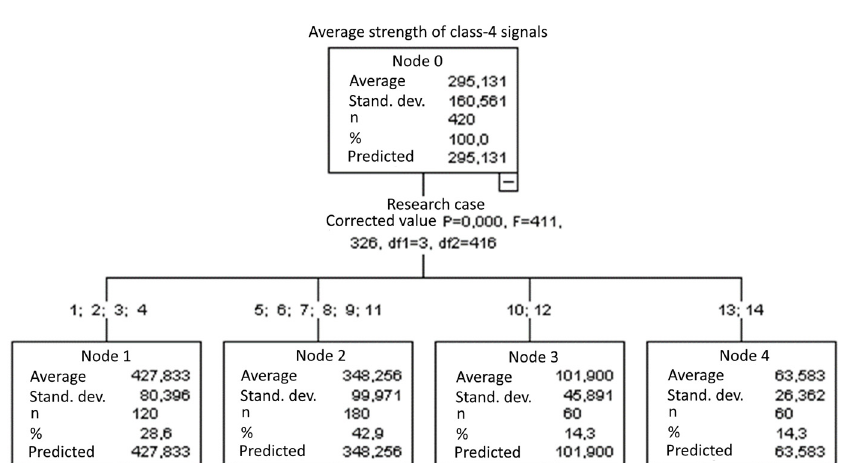
Figure 26. Classification tree for the average strength of class-4 signals.